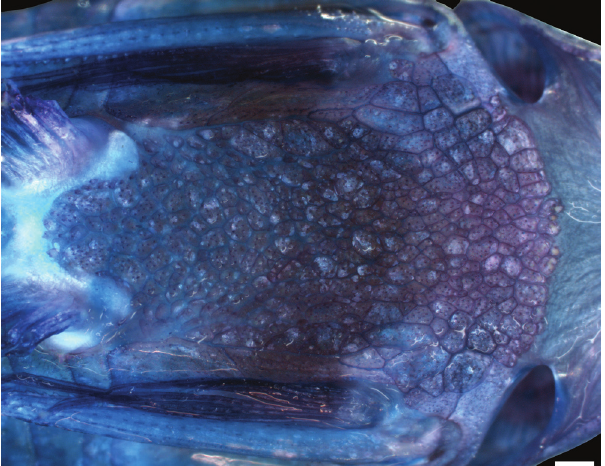
Fig. 4. Ventral surface of the trunk of Corydoras eversi , paratype, NUP 17310, 44.4 mm SL, showing the relatively large coalescent platelets covering the area between pectoral and pelvic girdles. Scale bar = 1.0 mm. Color in alcohol. Overall color of body in Fig. 1. Ground color of body brownish yellow, with top of head and snout dark brown. Ventral margin of orbit, above infraorbital 1, blackened. Maxillary barbel and anterior portion of outer mental barbel covered by black chromatophores. Dorsal and lateral portion of body, with exception of small region of ventrolateral body plates surrounding pelvic fin, densely covered by irregular black spots; spots arranged longitudinally on flanks, forming irregular stripes. Ventral region of body close to pectoral-fin spine origin with black spots in some specimens. Ground color of fins grayish brown. All fins covered by irregular black spots; pectoral, pelvic, anal, and caudal fins with black spots diffuse or absent in some specimens. Caudal fin generally with scattered spots, not forming transversal black bars; with faded spots arranged in up to six transversal slender black bars in few specimens. Color in life. Very similar to preserved specimens but with ground color of body intense orange; body covered by greenish yellow iridescent coloration (Fig.